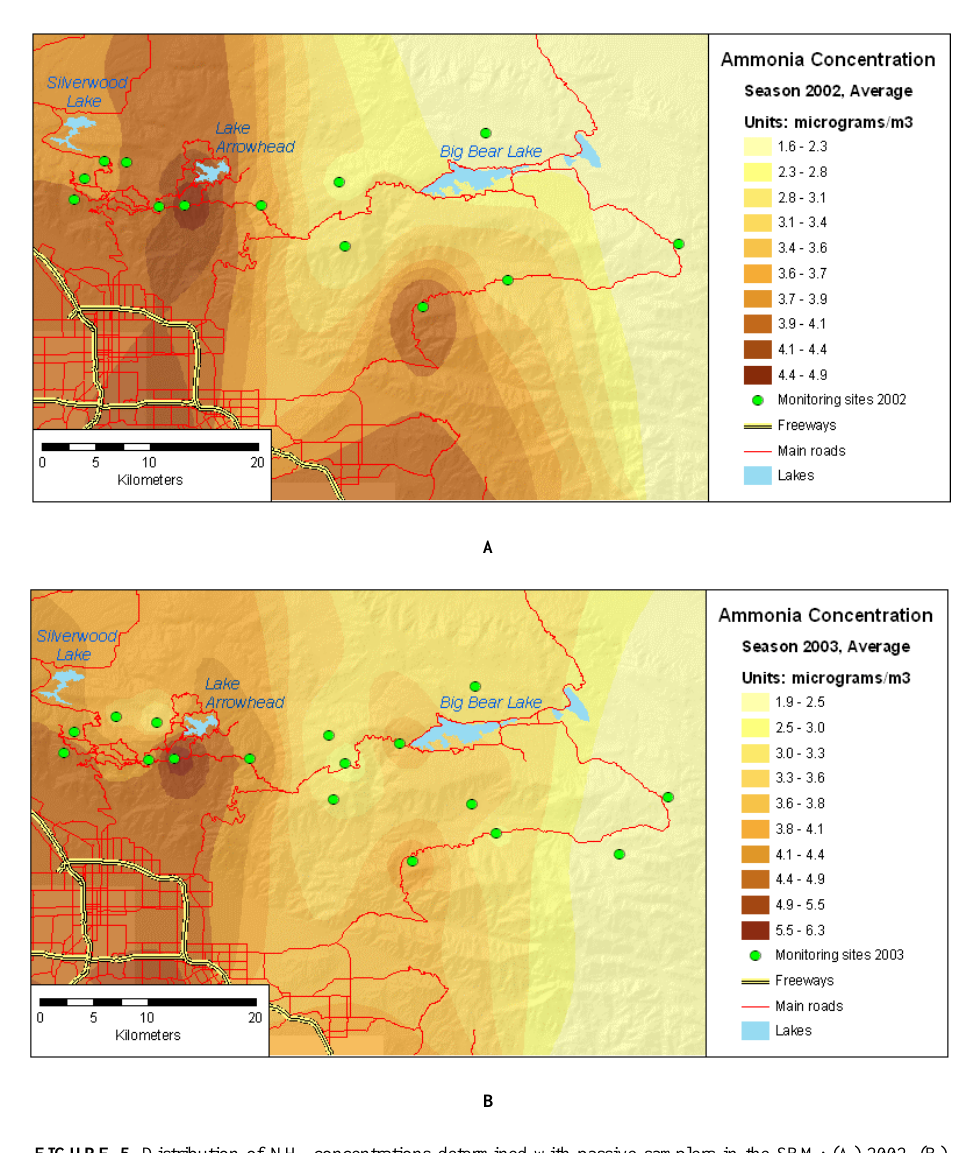
[21]. At same location during the 2002–2005 study, the June–August HNO μ g/m 3 for NH 3 between 1.7 in 2003 to 3.2 μ g/m 3 in 2002, with a 4-year mean of 2.5 μ g/m 3 . For NH between 2.8 in 2003 to 4.1 μ g/m 3 in 2004, with a 4-year mean of 3.3 μ g/m 3 . The recorded concentrations were very high; background levels of HNO in remote areas summer should not exceed 0.4 µg/m 3 [22] 3 while those for NH should be less than 1 µg/m 3 [23]. The observed increase in NH 3 reflect effects of the reformulation of gasoline that promotes higher production of reduced N compounds from combustion engines equipped with catalytic converters[24]. Reasons for the relatively high increase in HNO levels since 1991–1993 are not clear and will have to be further investigated. Elevated levels of 3 HNO and NH , especially in the western part of the range, explain why these areas experience high 3 3 levels of N deposition. Both HNO and NH have very high deposition velocities to foliar surfaces[23], 3 3 and can also be effectively taken up by